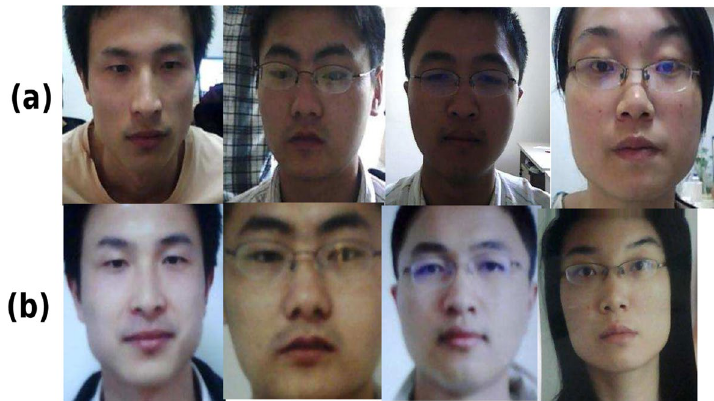
Fig. 14 Examples (both natural and spoof-print versions) from the original CASIA dataset